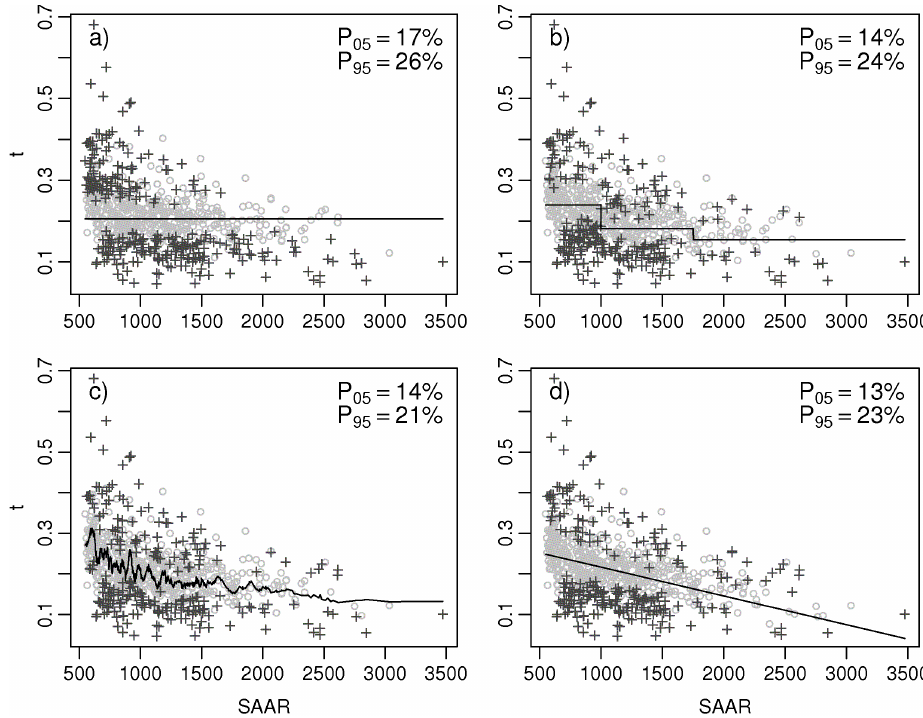
Fig. 7. Sample L-CV t versus mean annual precipitation SAAR in UK (data from the Flood Estimation Handbook, Robson and Reed, 1999). The black continuous line is the modeled regional value t R ; grey circles ( ◦ ) are sites for which the modeled t R is inside the 90% confidence interval for τ , when assuming the log-Student t sampling distribution of Eq. (14) and applying the corrections of Eqs. (16) and (17); black crosses (+) are sites for which it is outside of it. Four models are considered: (a) one unique region where t R = ¯ t ; (b) three regions with different SAAR; (c) regions obtained with a simplified ROI approach; (d) linear regression